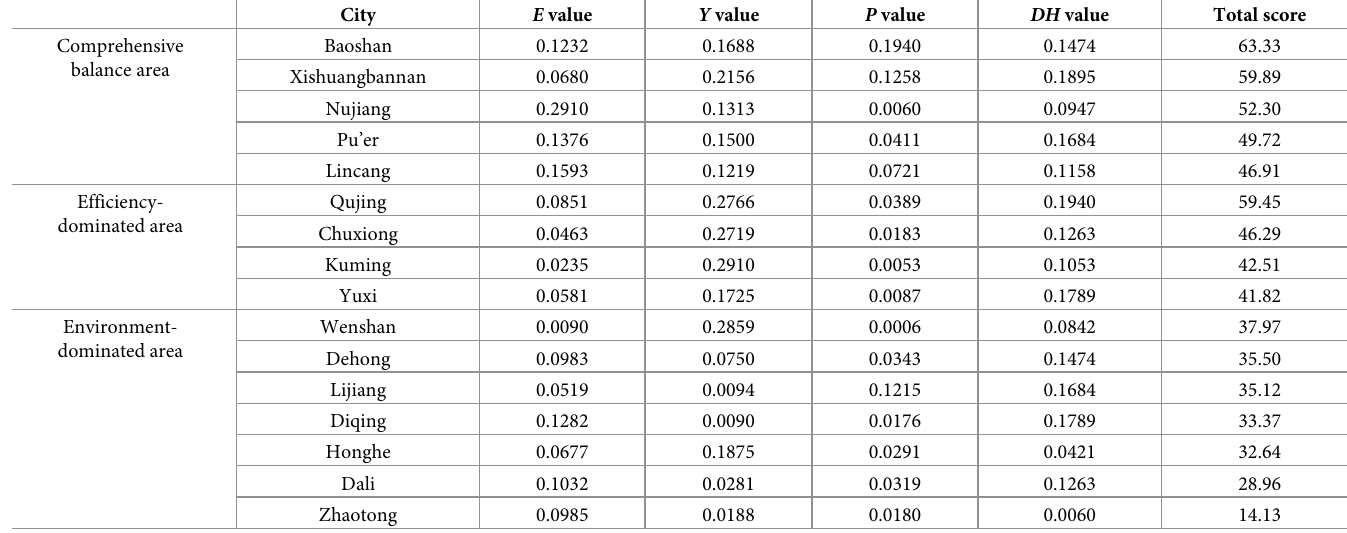
Table 6. Comprehensive scores of the ecological environment quality of each city in Yunnan